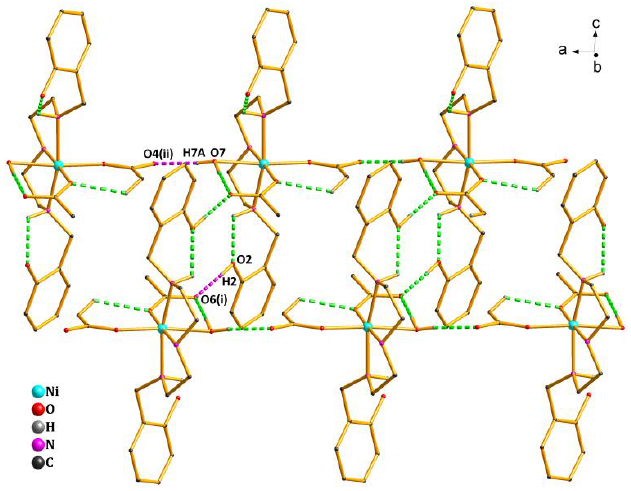
Figure 2. 1D ladder-like chain structure of Complex 1 via hydrogen bonds along the a axis. Symmetry codes: (i) 1 − x,1 − y,1-z; (ii) 1 +